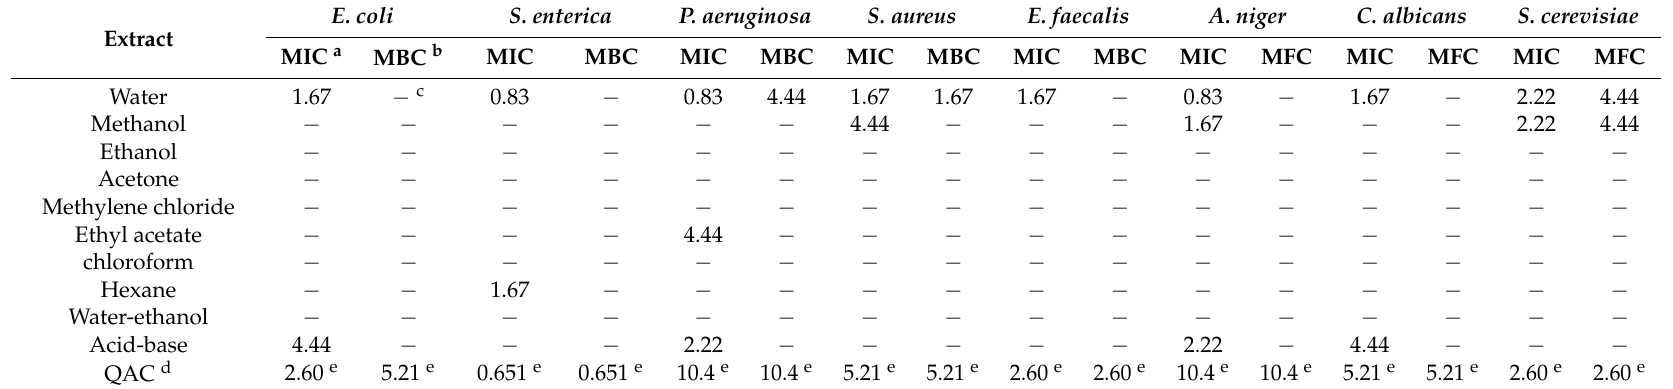
Table 1. Antimicrobial activity of quaking aspen bark extracts against different strains of microorganisms using the broth microdilution method. The ATCC numbers are E. coli (ATCC 35218), S. enterica (ATCC 10708), P. aeruginosa (ATCC 15442), S. aureus (ATCC 6538), E. faecalis (ATCC 29212), A. niger (ATCC 10535). C. albicans and